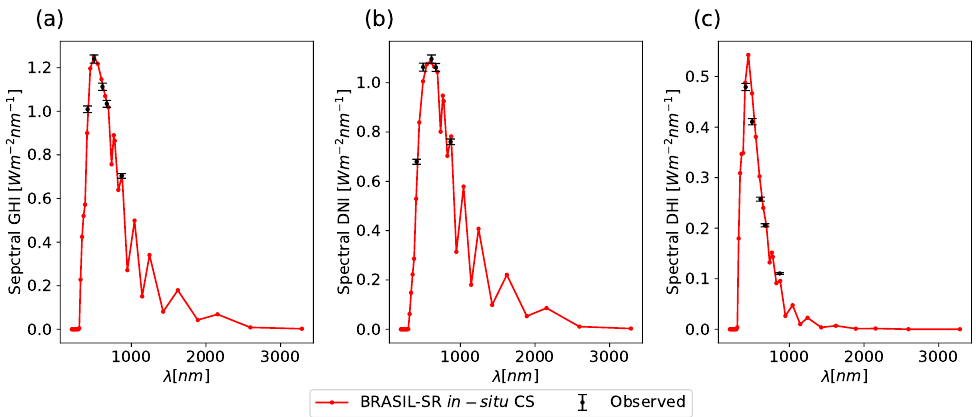
Figure A4. Spectral GHI ( a ), DNI ( b ) and DHI ( c ) at ARM_Manacapuru on 19 September 2015, 18:30